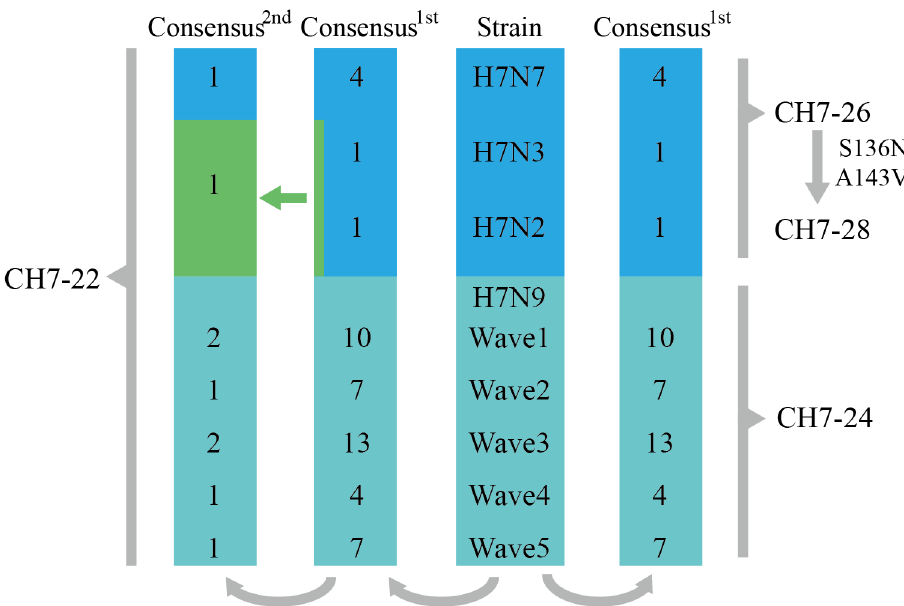
Figure 1. Schematic example of the layered consensus used for H7 COBRA design. The viruses were divided into four groups (H7N9, H7N7, H7N3, and H7N2) based on different HA/NA combinations. H7N9 viruses were further subdivided into five epidemic waves. Primary consensus amino acid sequences were derived from the three groups (H7N7, H7N3, and H7N2) and five subgroups (referred to five wave H7N9). CH7-26 was generated based on the primary consensus sequences of H7N7, H7N3, and H7N2. CH7-24 was obtained from the primary consensus sequences of five wave H7N9. Second consensus amino acid sequences were derived from primary sequences. Then, CH7-22 was designed based on all secondary consensus sequences. CH7-28 was derived from CH7-26 sequences by introducing S136N and A143V mutations. The green arrow refers to the secondary consensus, which was generated by alignment of the primary consensus of H7N3 and H7N2.